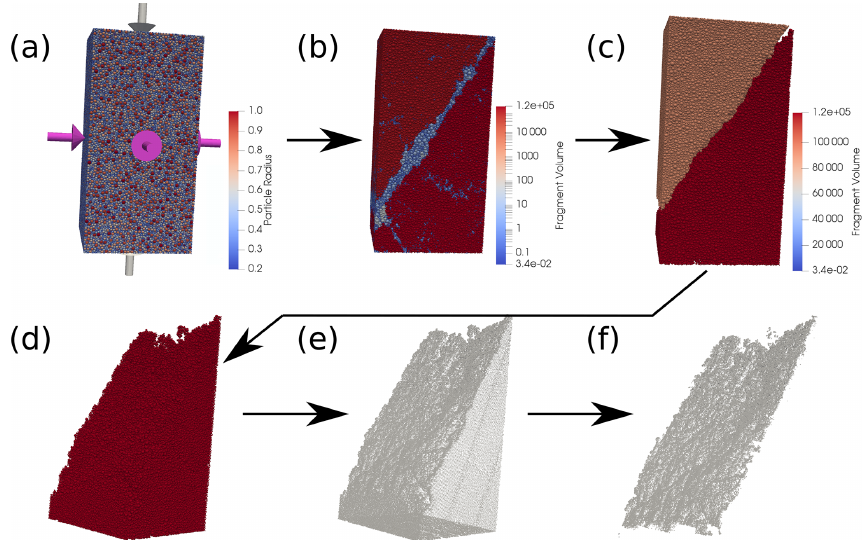
Figure 1. Numerical modeling workflow. (a) DEM specimen used for deformation experiments. Colors show particle size, purple arrows symbolize confining stress, gray arrows show compression direction. (b) Fragment identification in fractured DEM model. Colors show fragment size (red – large, blue – small). Red parts (top left and bottom right) show two major fragments, blue/white (i.e., fine-grained) material along diagonal shows shear zone. (c) Two major fragments extracted from fractured DEM model. Colors show fragment size (volume). (d) Fragment extracted from DEM model. Rough fracture surface visible. (e) Point cloud surface generated from DEM model. Outer surfaces of the initial DEM specimen visible right and bottom. (f) Filtered point cloud used for analysis. Non-fracture surfaces and outlying points removed.